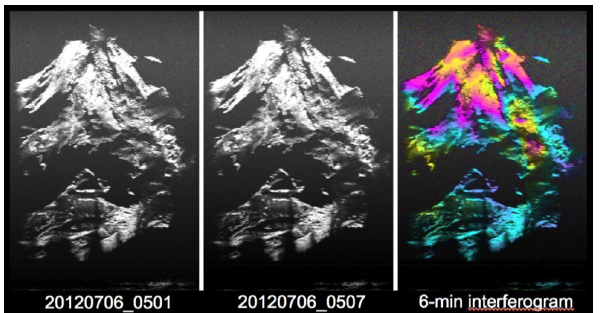
Figure A1. Photomosaic acquired from ROI viewpoint on 5 July 2012. Approximate glacier outlines shown in red.